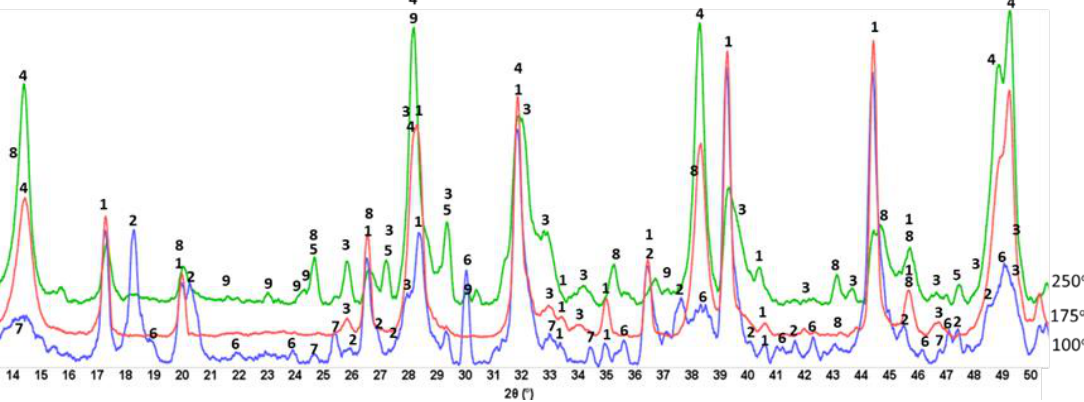
Figure 14. XRD patterns for 100-, 175-, and 250 °C-autoclaved CaP/HSA cements: 1-katoite (00-024-0217/01-077-0240/01-084-01354/01-074-9779); 2-gibbsite (01-076-1782); 3-hydroxyapatite (04-016-1647/04-011-6221/01-074-9779); 4-boehmite (04-010-5683); 5-calcium carbonate (01-085-6719); 6-krotite (00-023-1037); 7-grossite (00-023-1037); 8-hydrosodalite (00-040-0102); and 9-albite (01-089-6427).